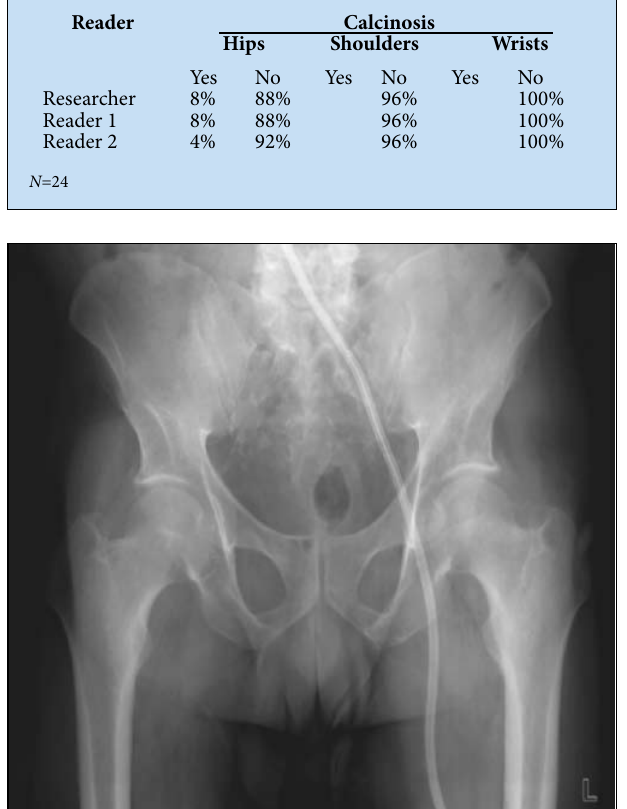
Fig. 2. Small area of calcification on the extensor surface of the left hip in keeping with calcinosis in a patient on haemodialysis for 15 months.